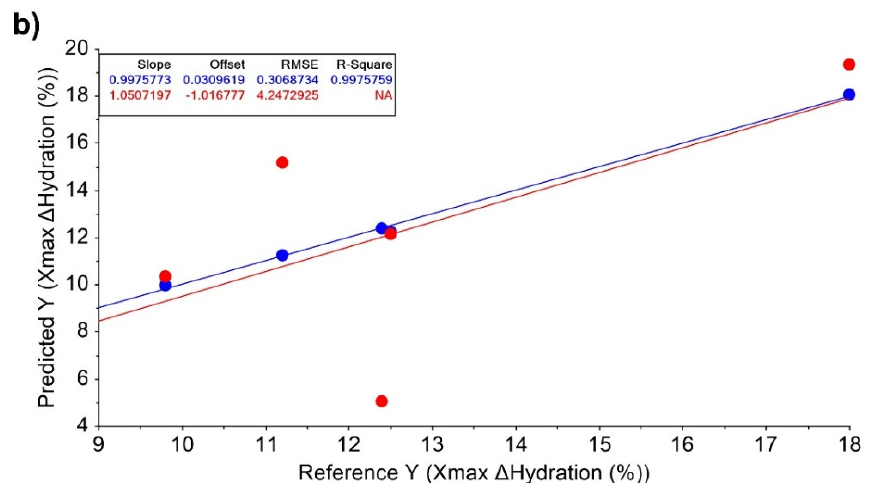
Figure 6. MLR models and fitting parameters for calibration and validation data for: ( a ) AuC ∆ oil and ( b ) Xmax ∆ Hydration. Blue and red circles represent calibration and validation data, respectively for MRL models. RMSE: Root Mean Square Error.